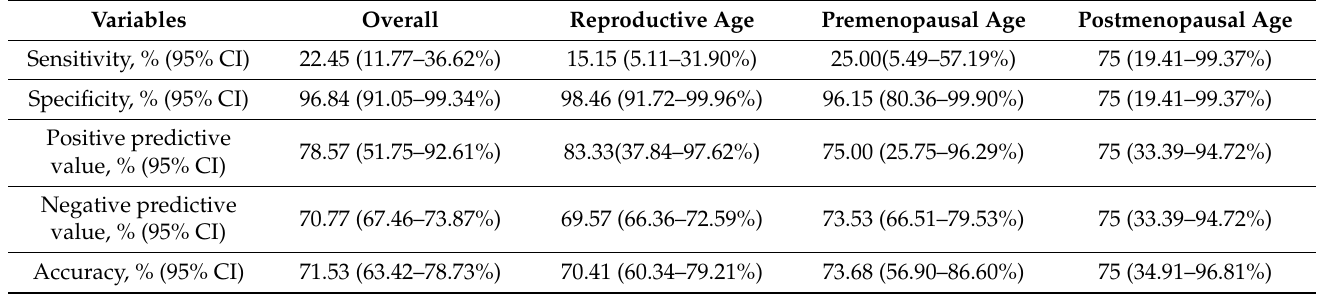
Table 4. Reliability of Pipelle biopsy for the evaluation of endometrial